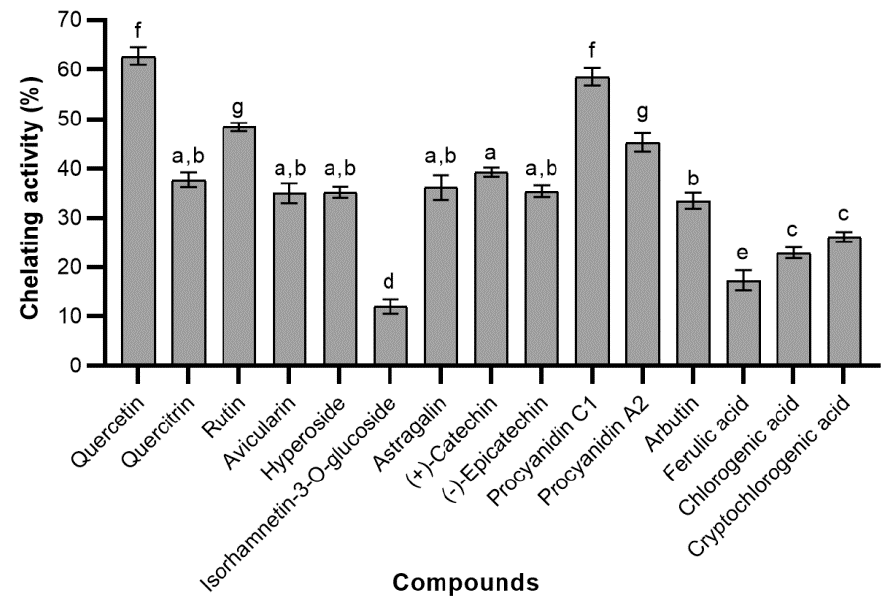
Figure 8. The chelating activity of tested phenolic compounds at a concentration of 20 µg/mL; bars without the same letters (a, b, c, d, e, f, g) indicate statistically significant differences between the means ( p < 0.05).